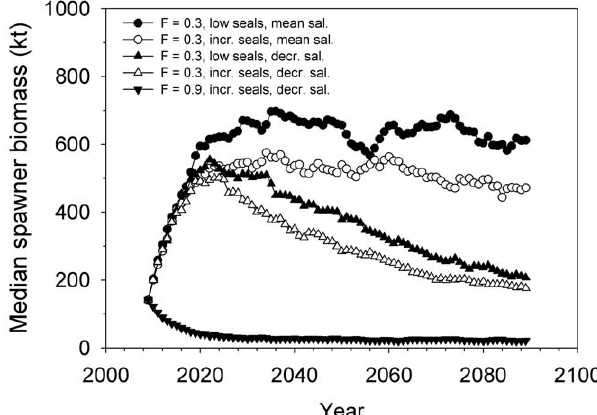
Figure 3. Temporal development of the projected median cod spawner biomass in the eastern Baltic Sea for different combinations of forcings (exploitation, seal predation, climate change induced salinity decline). See Methods and Table 1 for modelling details.